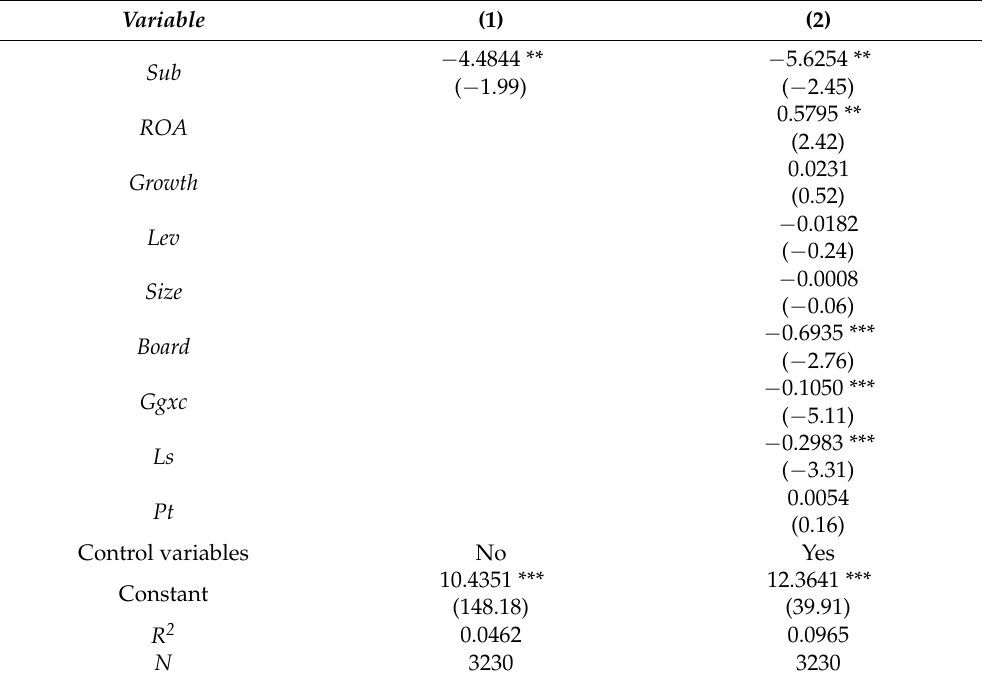
Table 3. Benchmark regression results.